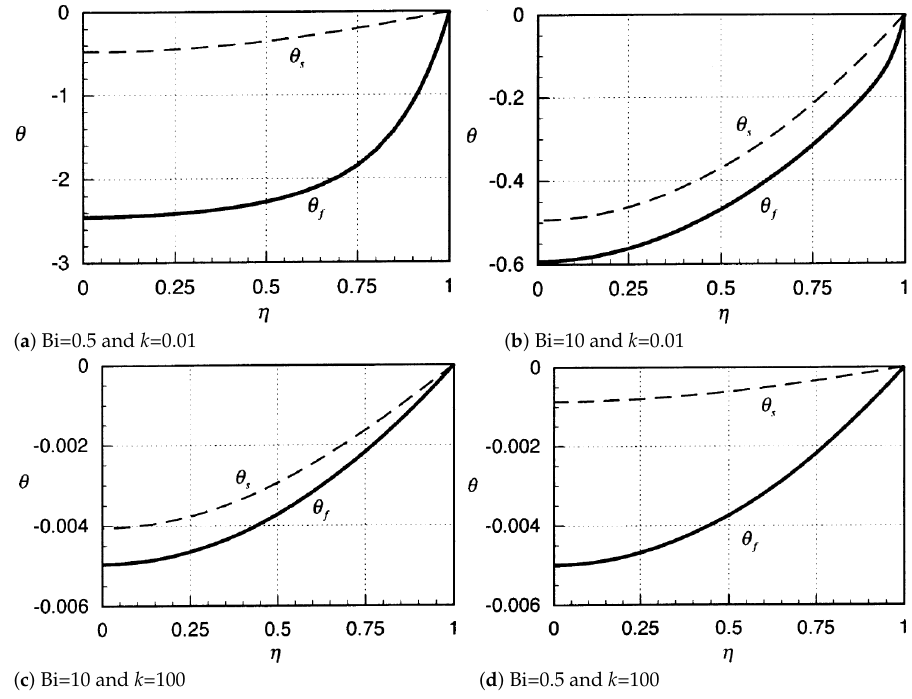
Figure 6. Profiles of local temperature difference ( θ ) between the solid and fluid phases for different Biot numbers (Bi) and solid/fluid thermal conductivity ratio ( k r ) , reported by Lee and Vafai [37].